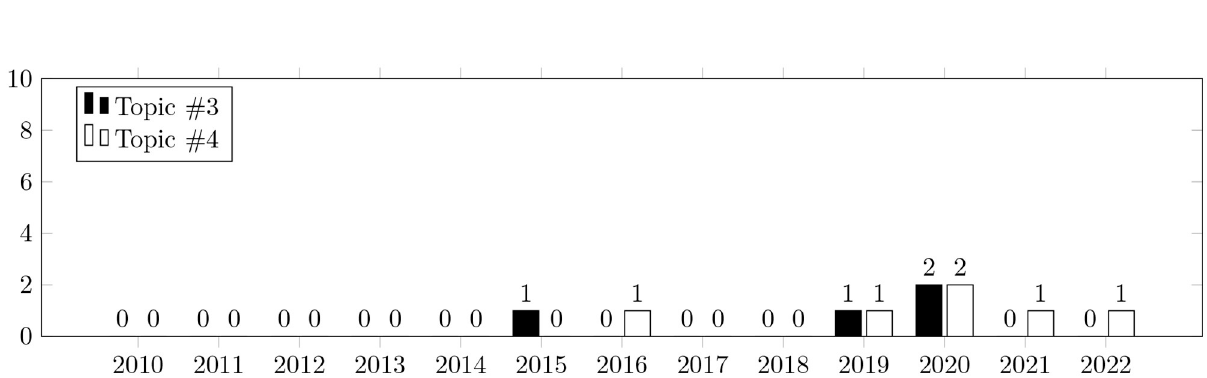
Fig 5. Topics distribution by year of publication. The bars show the number of papers related to the key topic published in a particular year. Black bars show the number of papers related to “bug prioritization”. White bars show the number of papers related to “bug severity and prediction”.